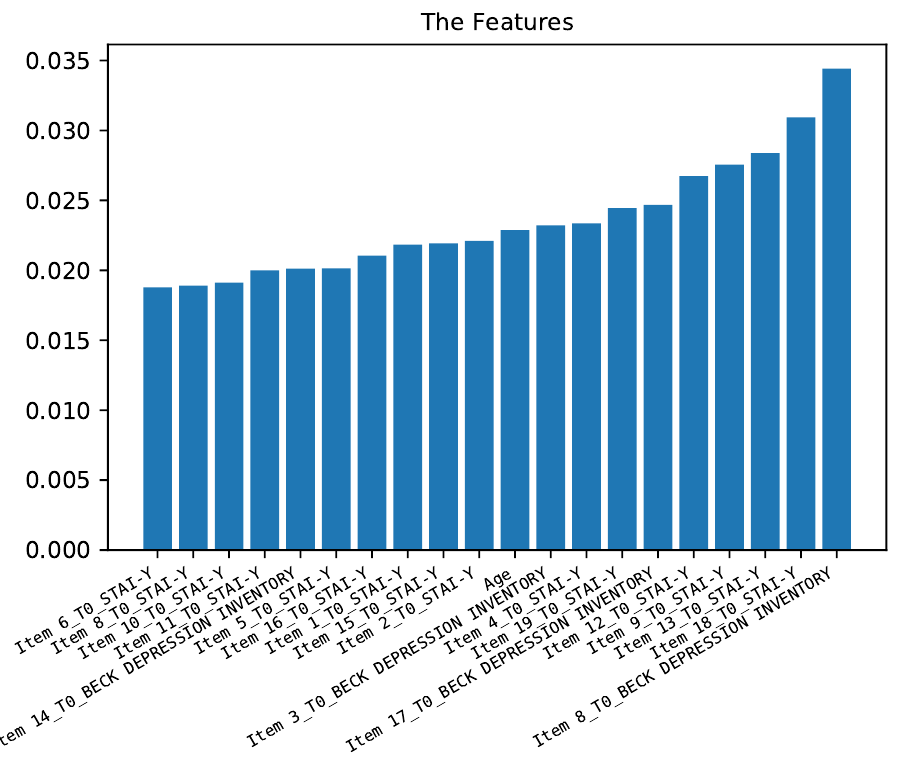
Figure 5. Importance of the different features for predicting anxiety symptoms.